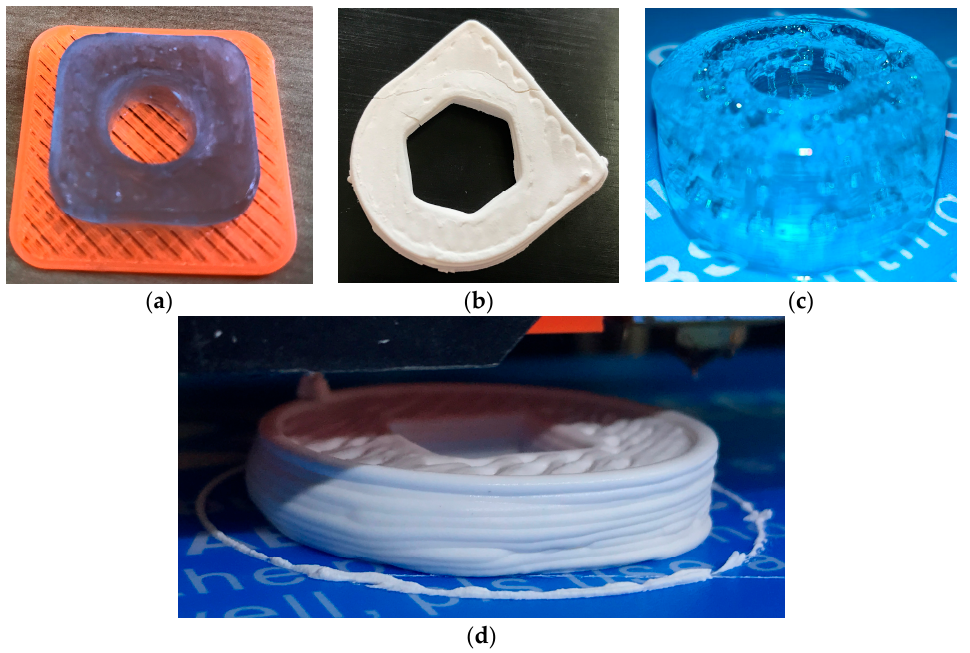
Figure 12. Test sample surface quality ( a ) Cylindrical surface, silicone ( b ) Top surface, silicone ( c ) Cylindrical surface, acrylonitrile-butadiene-styrene (ABS) ( d ) Top surface, ABS.